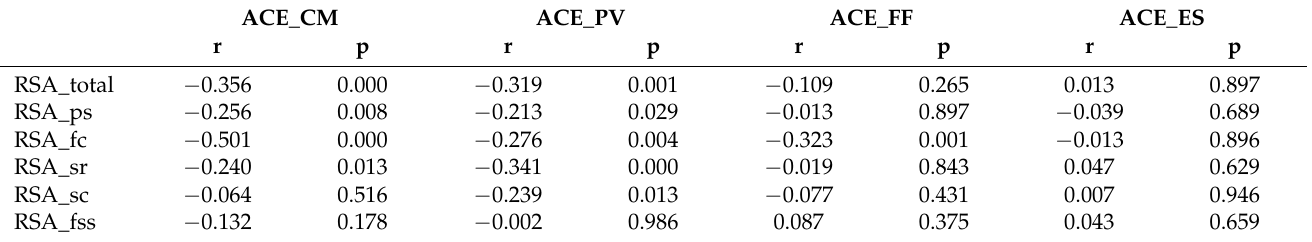
Table 1. Correlation matrix between Adverse Childhood Experiences and Resilience Scale for